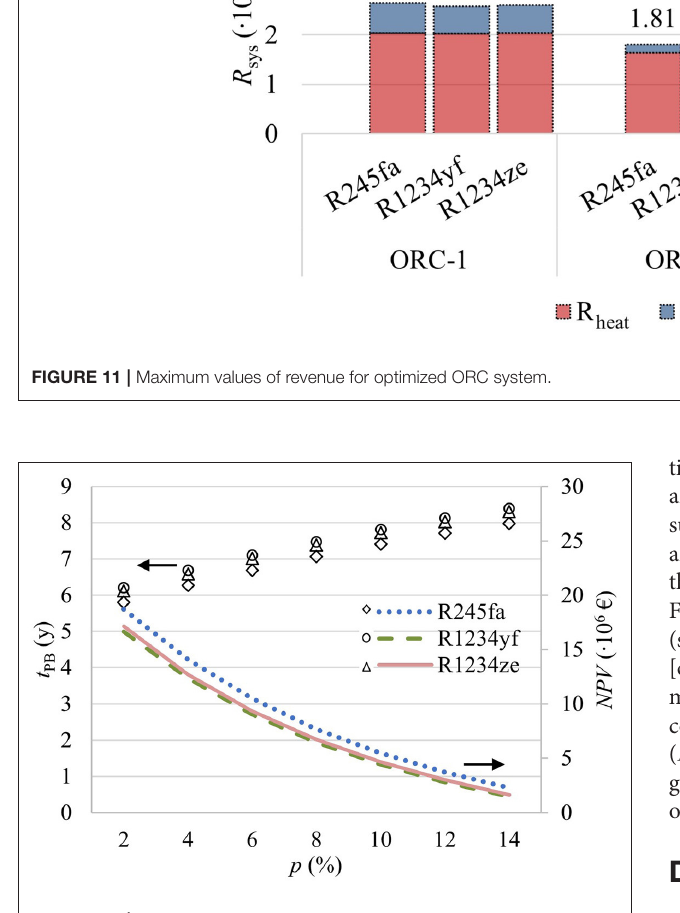
FIGURE 12 | Payback period and net present value vs. discount